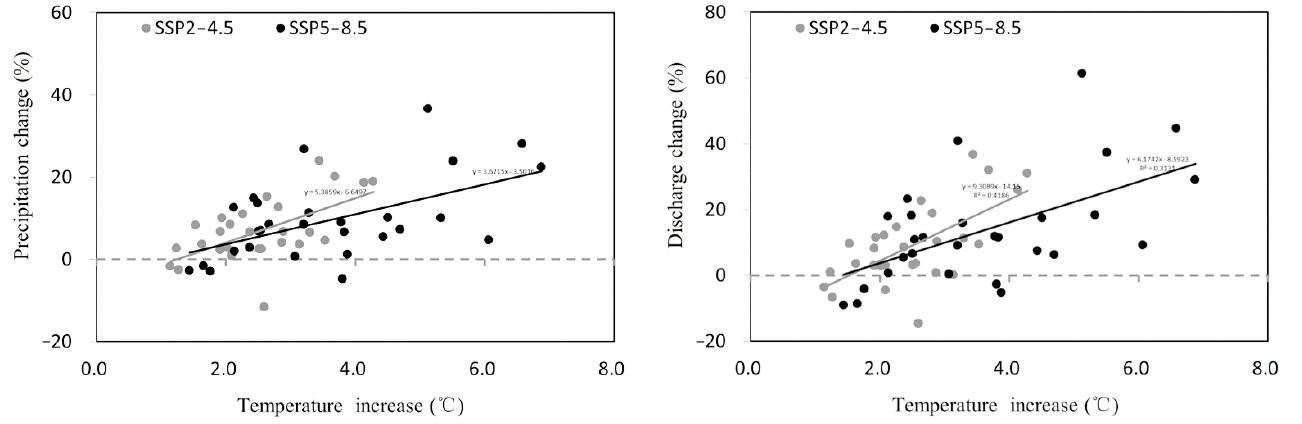
Figure 9. Relationship of projected changes in annual precipitation and river flow to annual temperature increase in the Fujiang River basin (relative to 1971 – 2010).